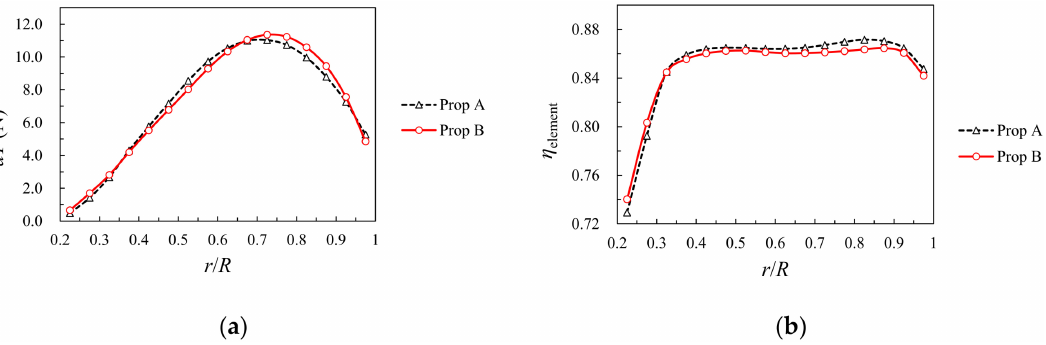
Figure 35. Aerodynamic characteristics along the blade of two propellers at State 2: ( a ) Distributions of blade element thrust; ( b ) Distributions of blade element efficiency.